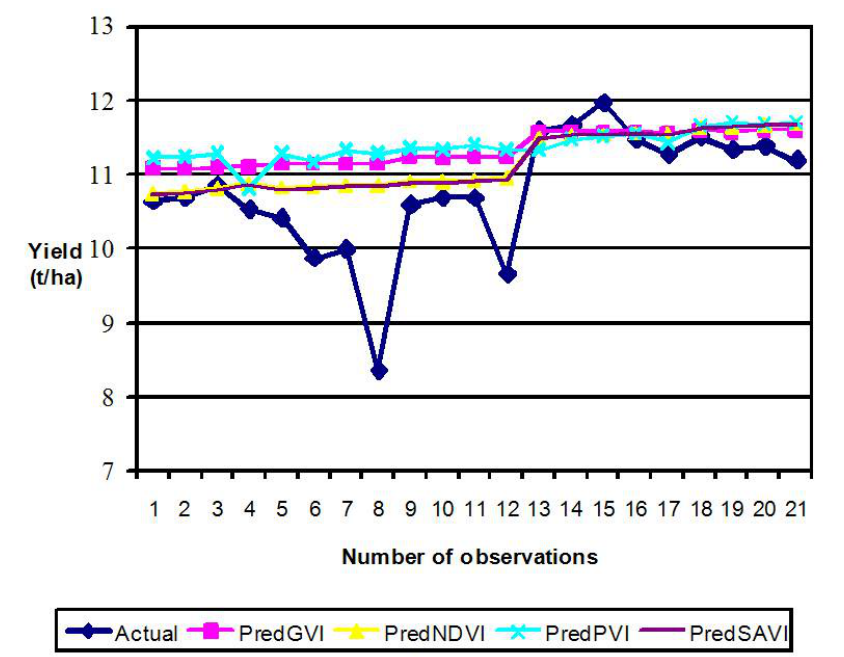
Figure 10. Comparison of VI-NN model prediction ability for the year 1999.